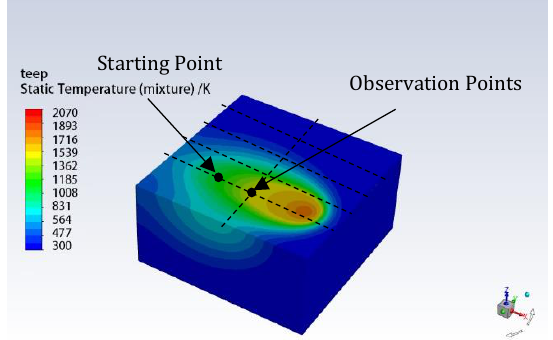
Figure 19. Schematic diagram of the location of the observation point.